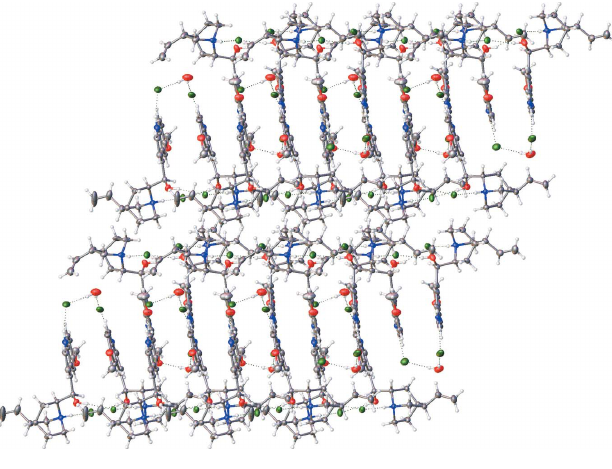
Figure 3 Packing diagram of the title compound viewed from the (110)